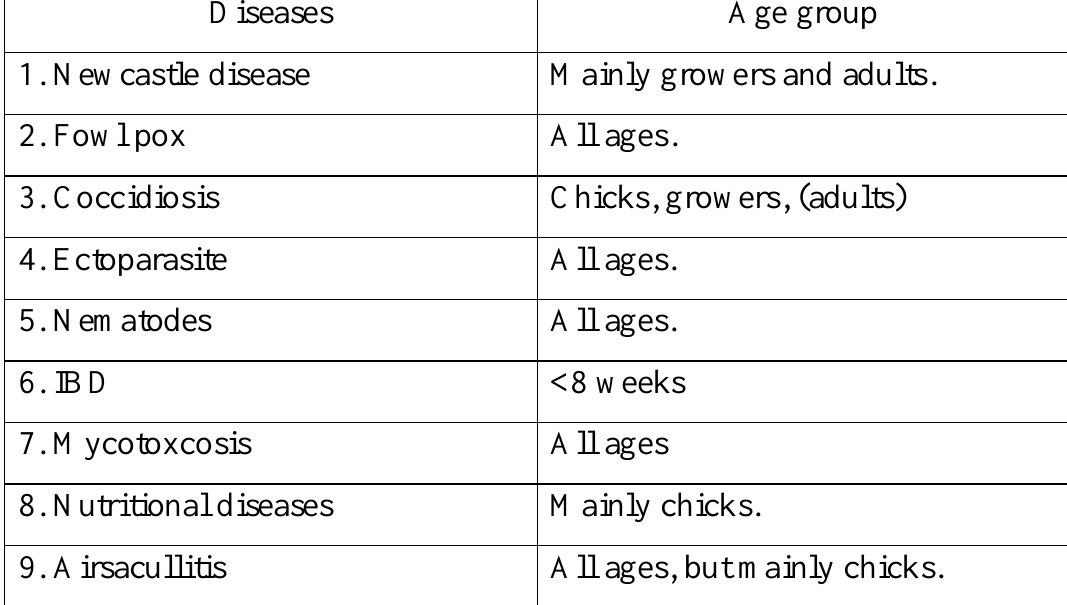
Table (1): Important diseases in free – range chickens and the age group in which the disease is most often